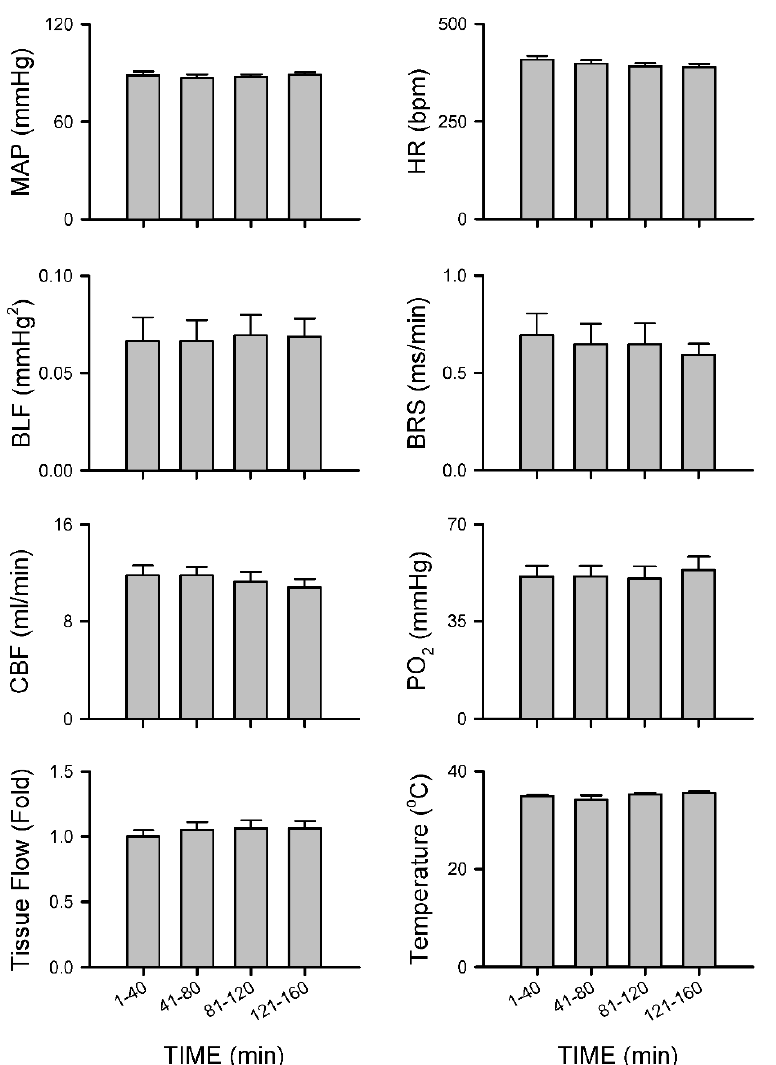
Figure 9. Insignificant changes of MAP, HR, BLF, BRS and CBF or tissue perfusion, PO 2 or temper- ature in the cerebral cortex under 1.5% isoflurane anesthesia alone. Note values for MAP, HR, BLF and BRS are mean ± SEM of 14 animals (7 from Group 4 CBF experiments plus 7 from Group 4 tissue perfusion experiments); values for CBF are mean ± SEM of 7 animals; and values for tissue perfusion, PO 2 or temperature in the cerebral cortex are mean ± SEM of 7 animals. No significance among all groups ( p > 0.05).